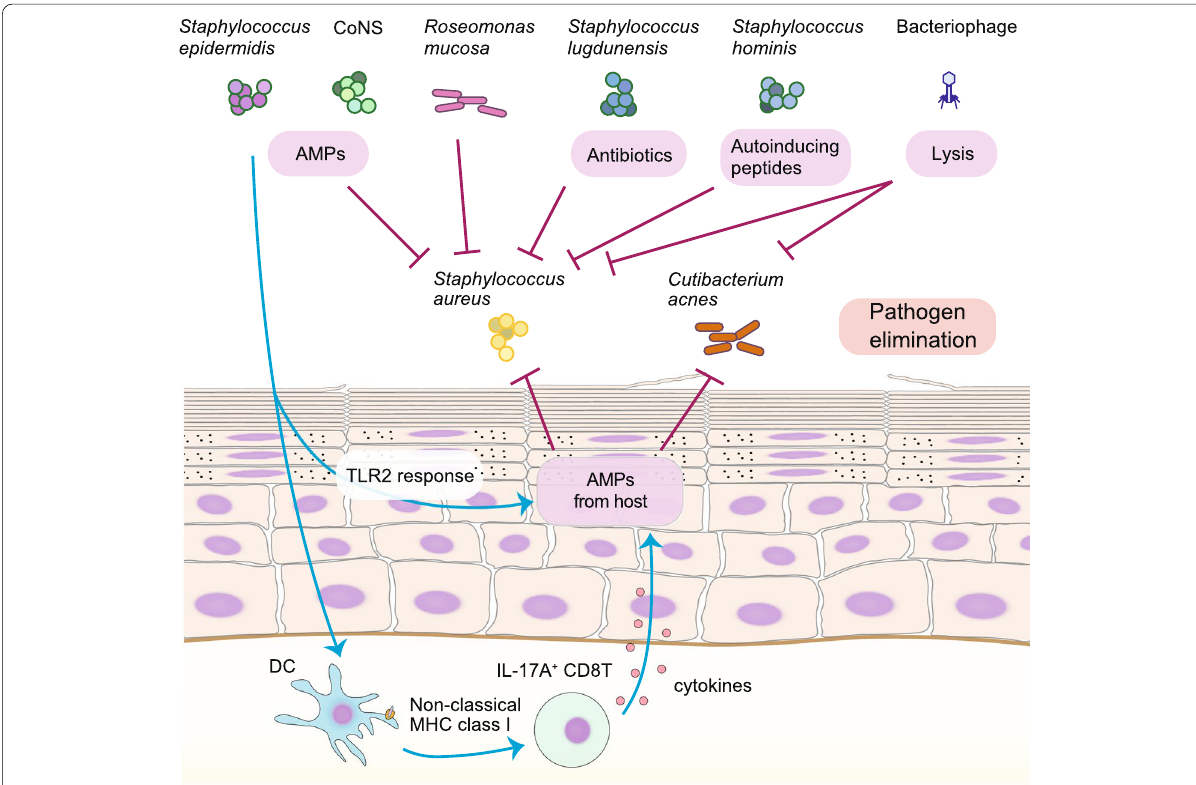
Fig. 3 Potentially therapeutic skin microbiota by pathogen elimination. Engraftment of specific skin microbiota that play a role in killing the pathogen is a therapeutic strategy for skin inflammatory diseases such as atopic dermatitis and acne. Colonization of Staphylococcus aureus is inhibited by bacterial metabolites such as antimicrobial peptides (AMPs), autoinducing peptides, and antibiotics. Bacteriophages kill and lyse the bacteria that they infect. Staphylococcus epidermidis promotes the production of AMPs from host cells through the Toll-like receptor 2 (TLR2) response. Dendritic cells (DCs) capture S. epidermidis and induce IL-17A CD8T cells via a nonclassical MHC I-restricted pathway. Induced IL-17A + + CD8T cells produce cytokines that stimulate keratinocytes to produce AMPs against